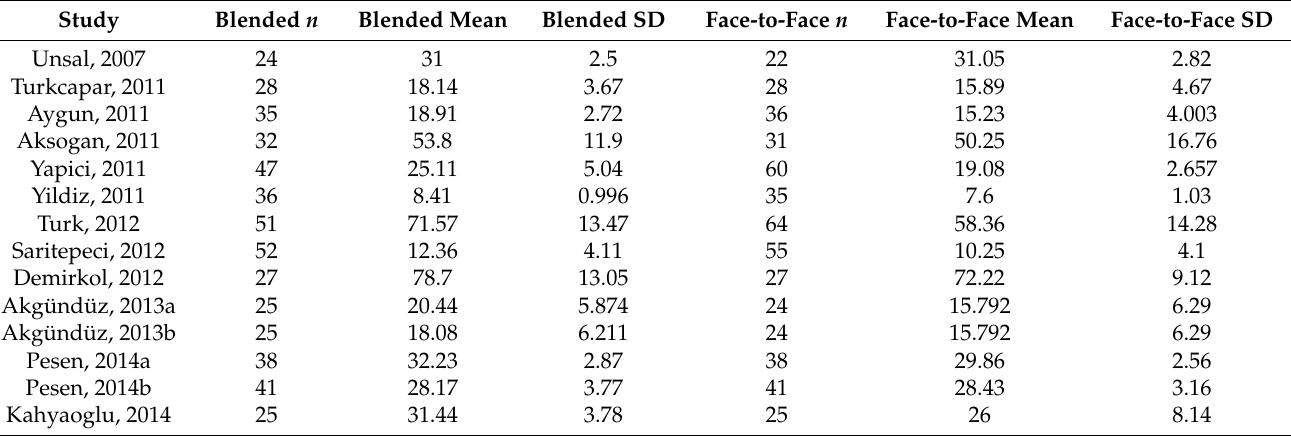
Table 2. Sample Raw Dataset [49] for Standardized Mean Difference